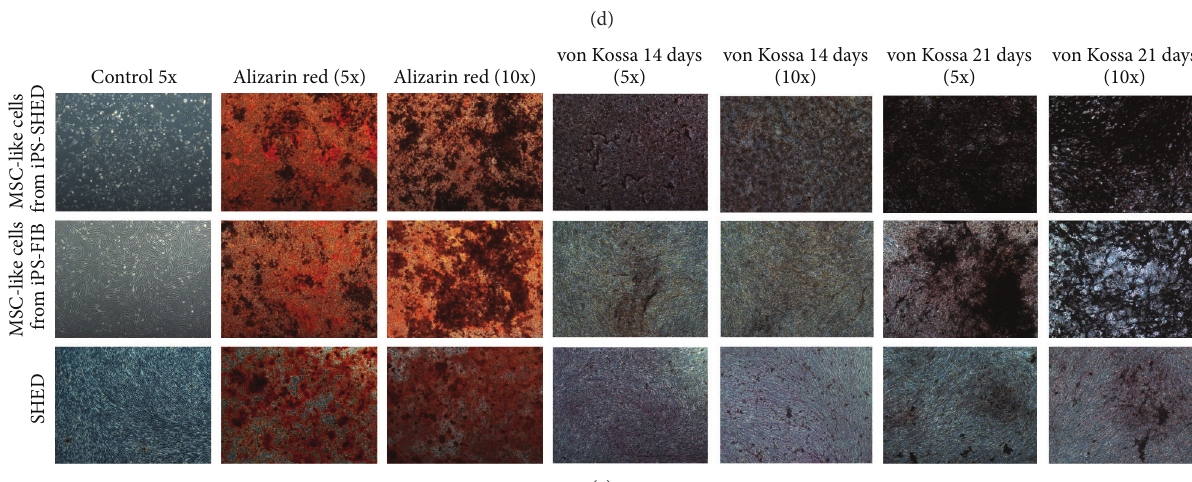
Figure 3: (a) Real-time quantitative PCR analysis of alkaline phosphatase ( ALP ), DLX5 , RUNX2 , BGLAP, and COL1A1 in MSC-like cells from iPS-SHED, MSC-like cells from iPS-FIB and SHED. ACTB , TBP , and HMBS were used as endogenous controls. (b) Alkaline phosphatase activity quantification in cells cultured for 9 days in osteogenic medium. Values represent means +/ − SD, 𝑃 < 0.01 ( ∗∗ ), and 𝑃 < 0.001 ( ∗∗∗ ). (c) Alizarin red S staining quantification in cells cultured for 21 days in osteogenic medium. Values represent means +/ − SD, 𝑃 < 0.001 ( ∗∗∗ ). (d) Real-time quantitative PCR analysis of CD105 in undifferentiated SHED and MSCs from iPS-SHED and from iPS-FIB. ACTB , TBP, and HMBS were used as endogenous controls. Values represent means +/ − SD, 𝑃 < 0.001 ( ∗∗∗ ). (e) Representative pictures of alizarin red S (after 21 days of in vitro osteoinduction, with 5 and 10x magnification) and von Kossa staining (after 14 and 21 of in vitro osteogenic induction, with 5 and 10x magnification) of mineralized deposits in MSC-like cells from iPS-SHED, MSC-like cells from iPS-FIB and SHED. Basal growth medium free of osteoinduction factors was used in the control group (with 5x